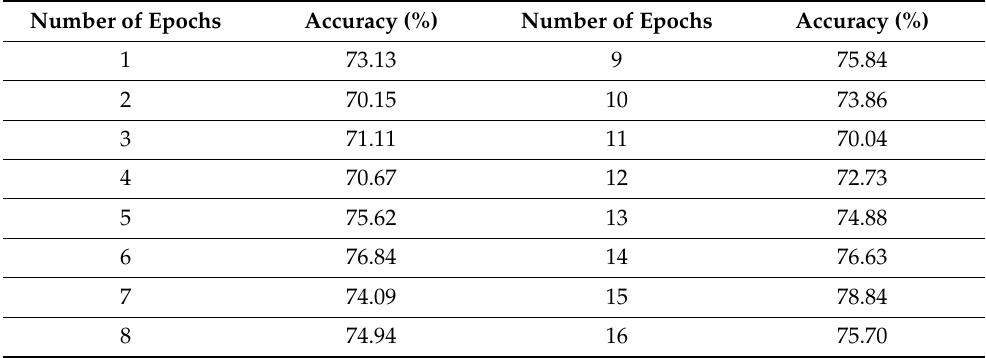
Table 5. Identification accuracy results for the deviation range of inclination angles through 16 learning epochs.